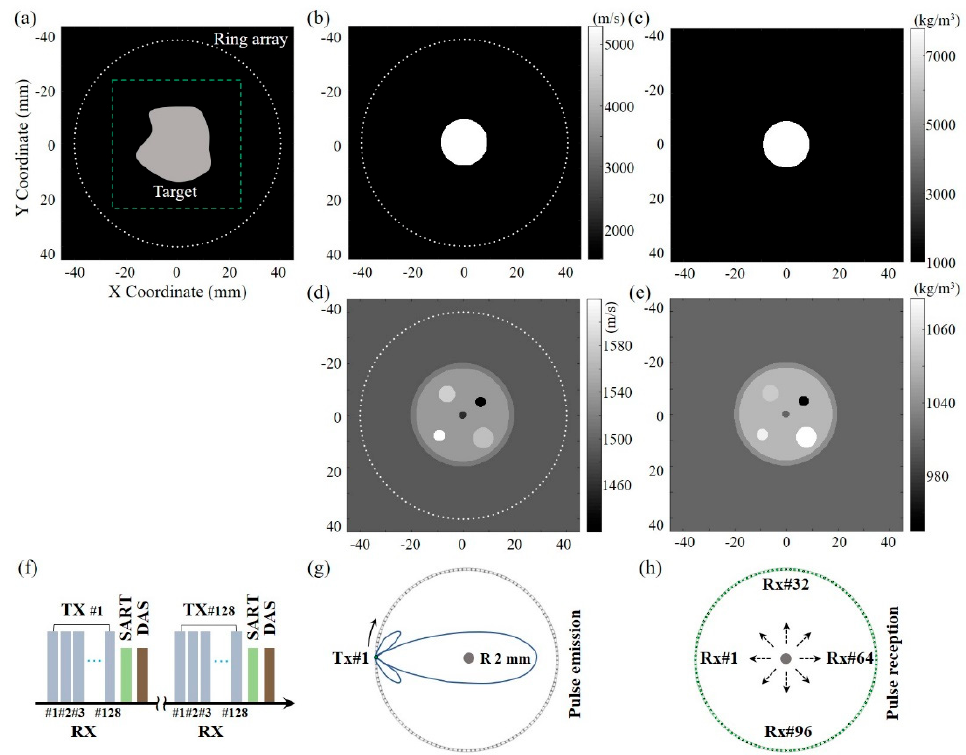
Figure 1. Simulation configuration of the ring array USCT. ( a ) Simulation setup. The medium speed ( b ) and density ( c ) of circular steel target. The medium speed ( d ) and density ( e ) of multi-layer targets. ( f ) Imaging sequence. Pulse emission ( g ) and reception ( h ) schematic in the first